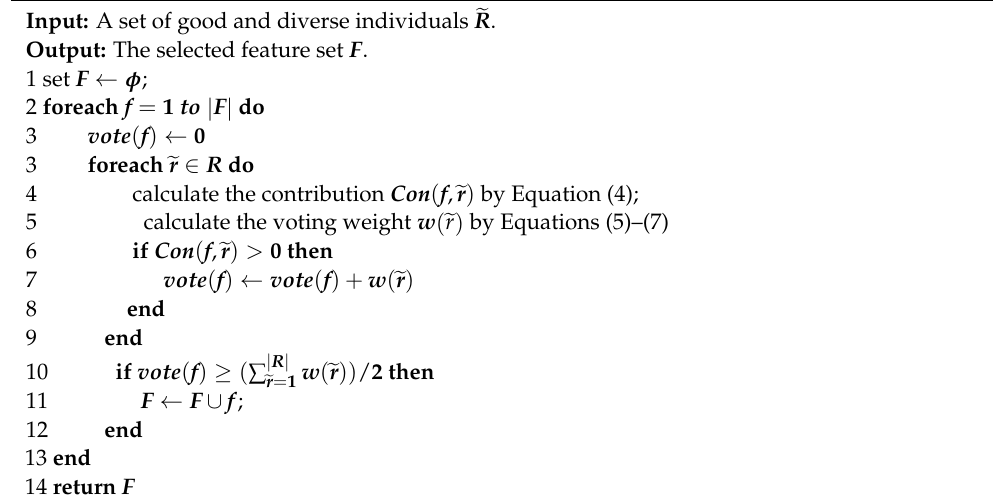
Algorithm 3. Feature Selection